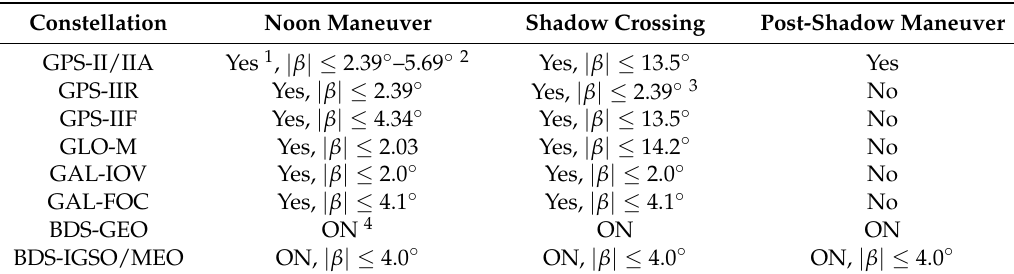
Table 2. The average threshold value for different periods of GNSS attitude